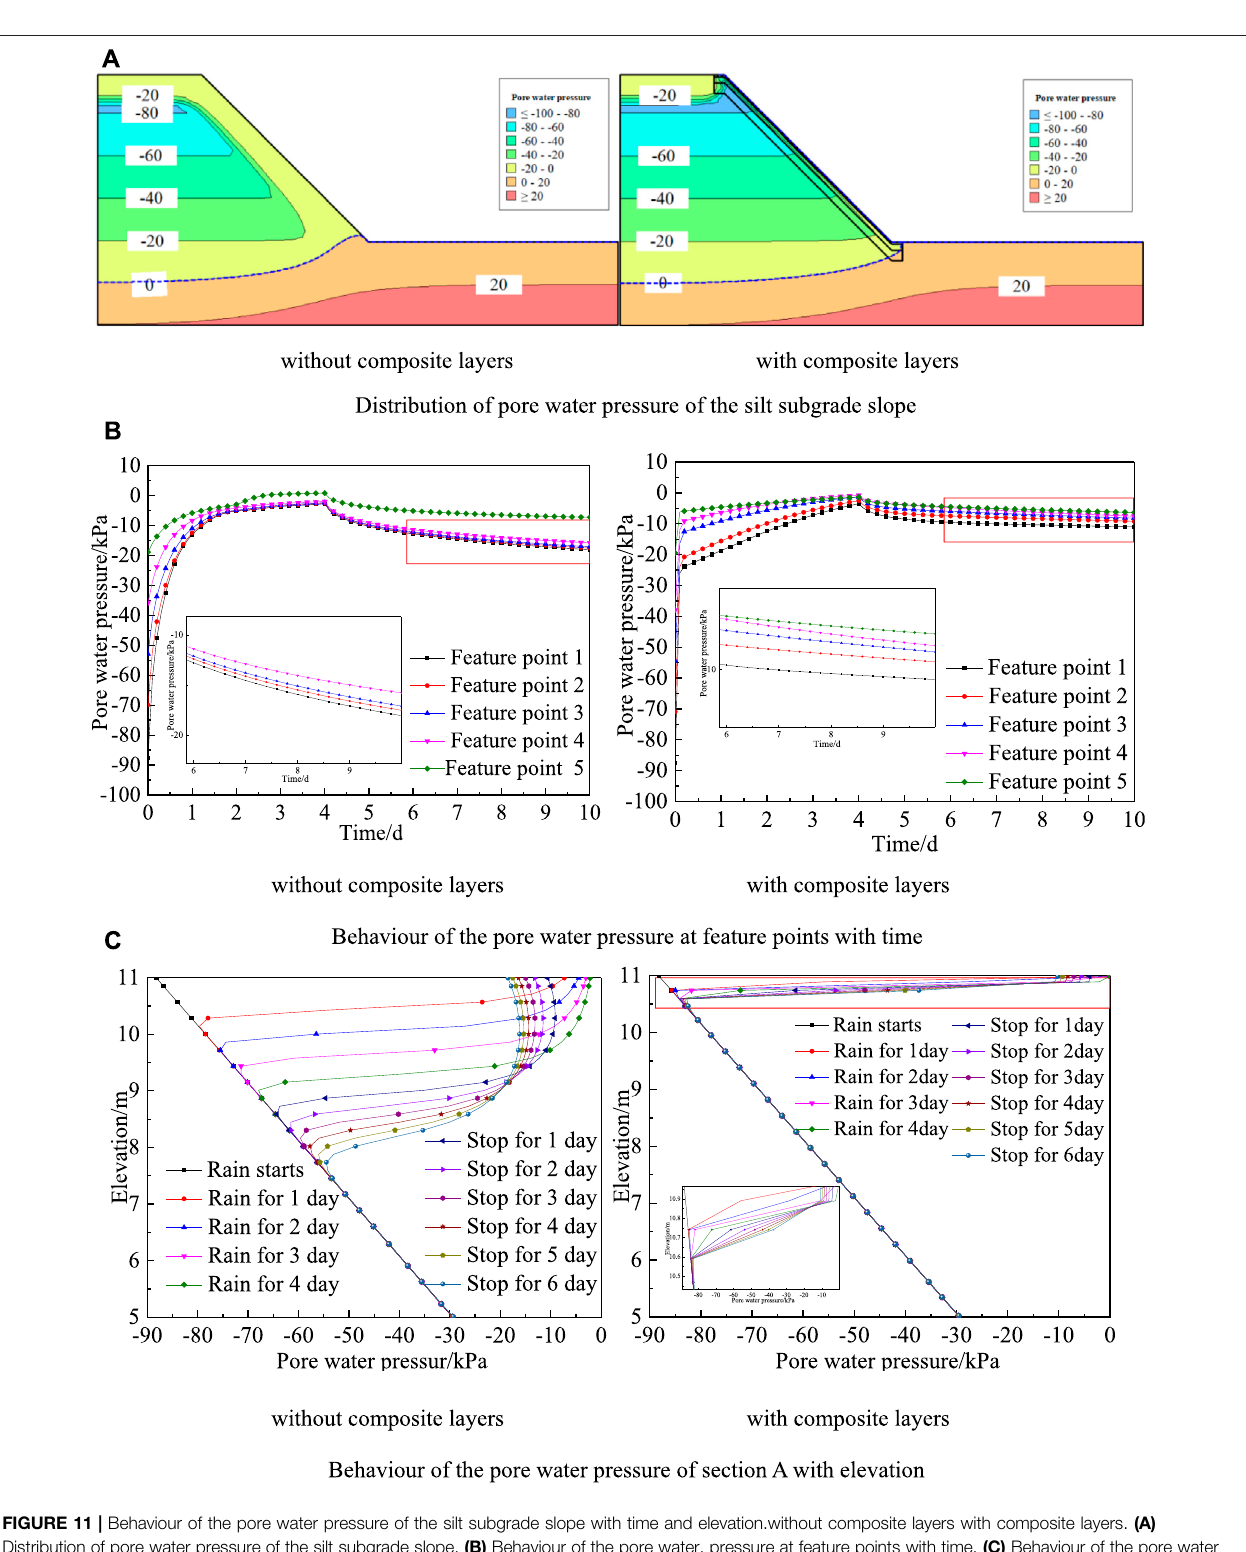
Frontiers in Earth Science |